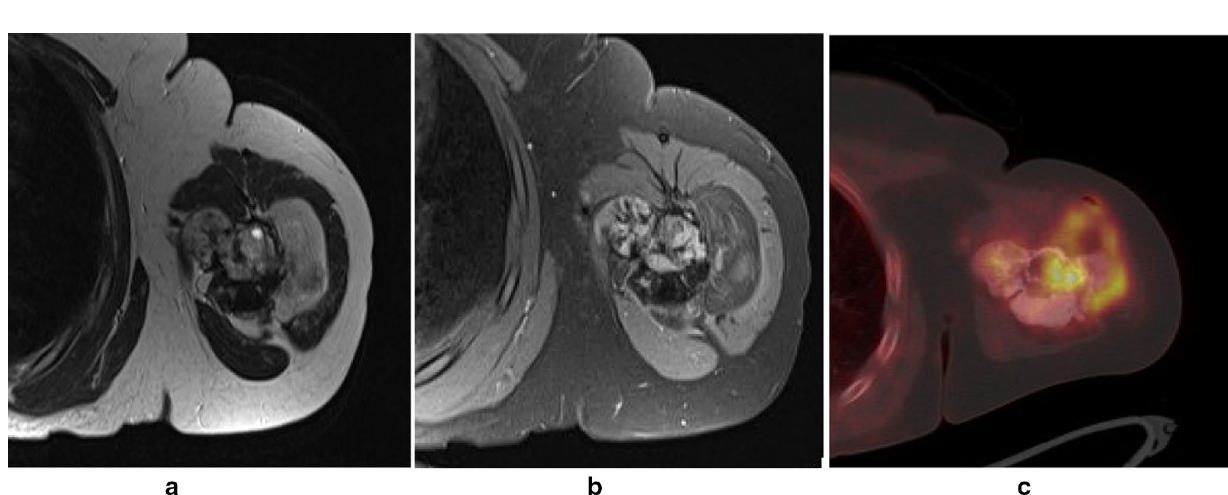
Fig. 2 MRI and FDG-PET of the left humerus. a T2-weighted image showing the differing signal intensities of the tumor components with low T2 signal in the densely sclerotic part and signal equivalent to fat corresponding to the radiographic lucency. b T1-weighted image post contrast with fat suppression confirming the fatty nature of the lateral part of the tumor and showing moderate uptake of gadolinium. c FDG-PET-CT image of the tumor depicting a moderate uptake (SUV